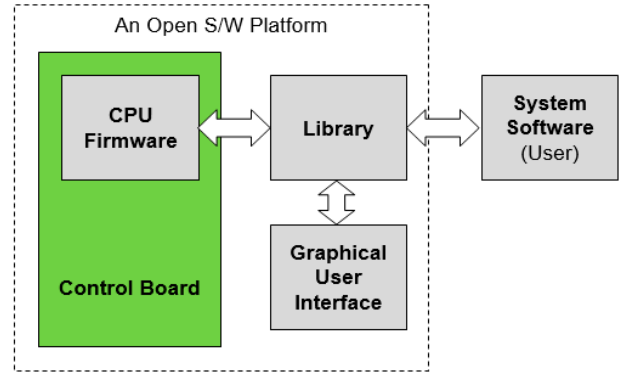
Figure 7. Flowchart of an open software (S/W) platform. Electronics 2019 , 8 , 200